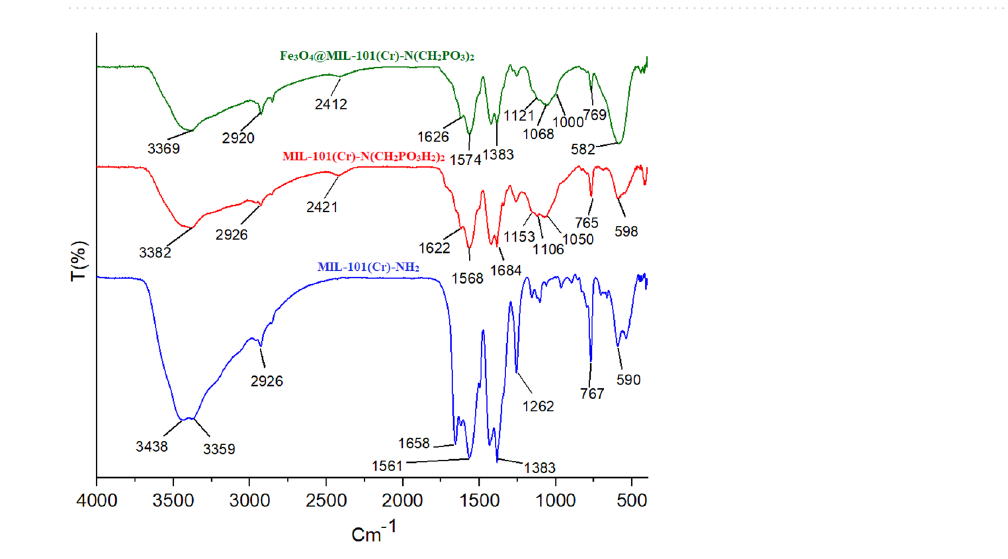
Figure 4. FT-IR spectra of catalyst and starting